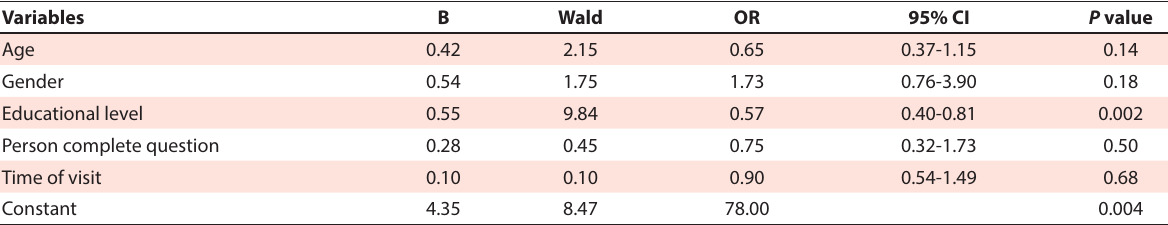
Table 3. Logistic regression used for factors affecting on patient satisfaction